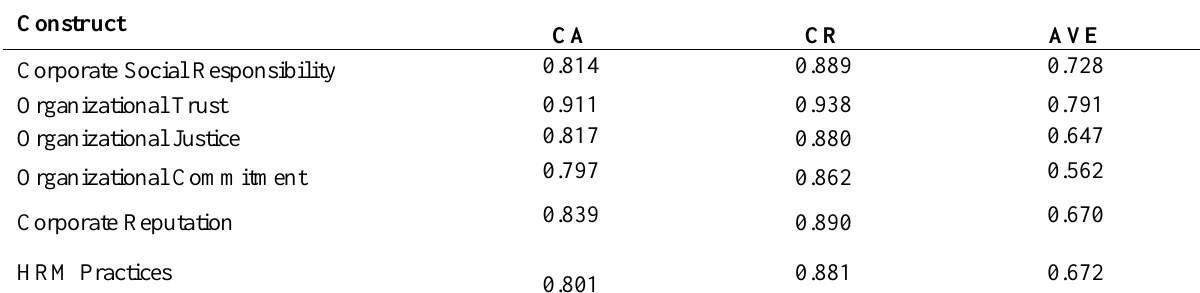
Table.1:Constructs Validity